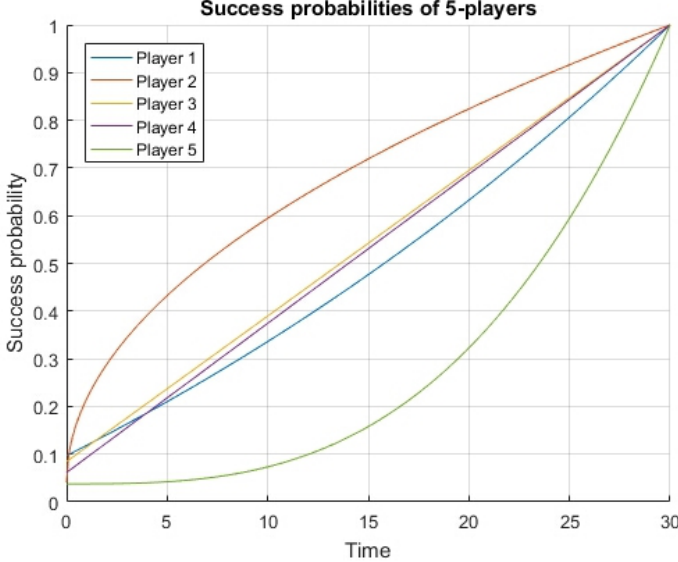
Figure 1. Success probabilities for a five-person duel game.